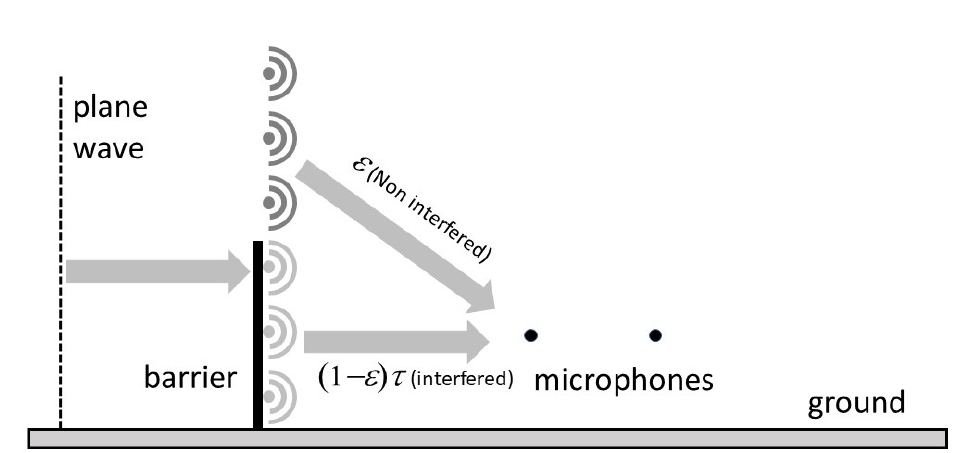
Figure 1. Schematic representation of a noise barrier, showing the application of the Huygens–Fresnel– Kirchhoff